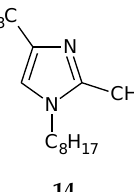
Figure 5. The 1-octyl-2,4-dimetylimidazole molecule.